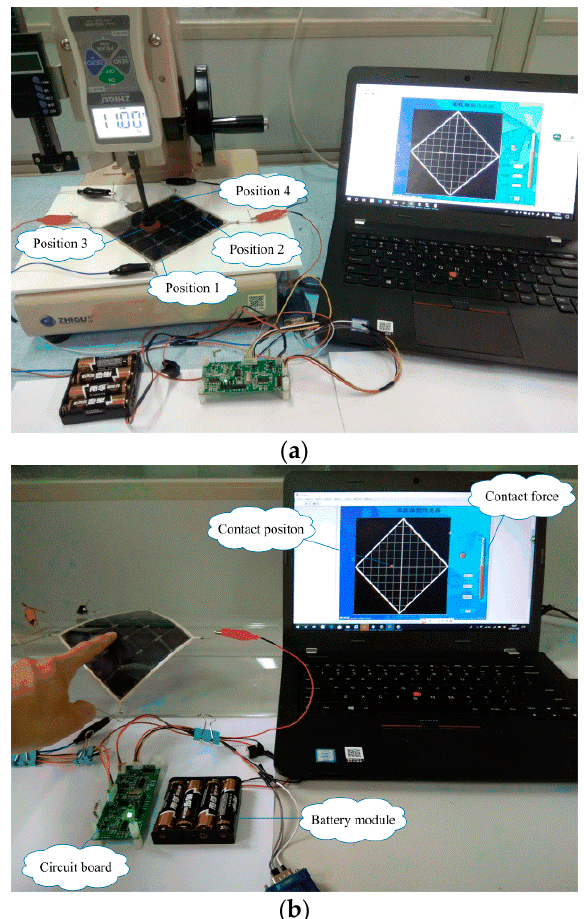
Figure 17. The test device. ( a ) The tactile sensor was used to detect the contact position and force; ( b ) using a finger to touch the tactile sensor when it was pasted onto the curved panel.